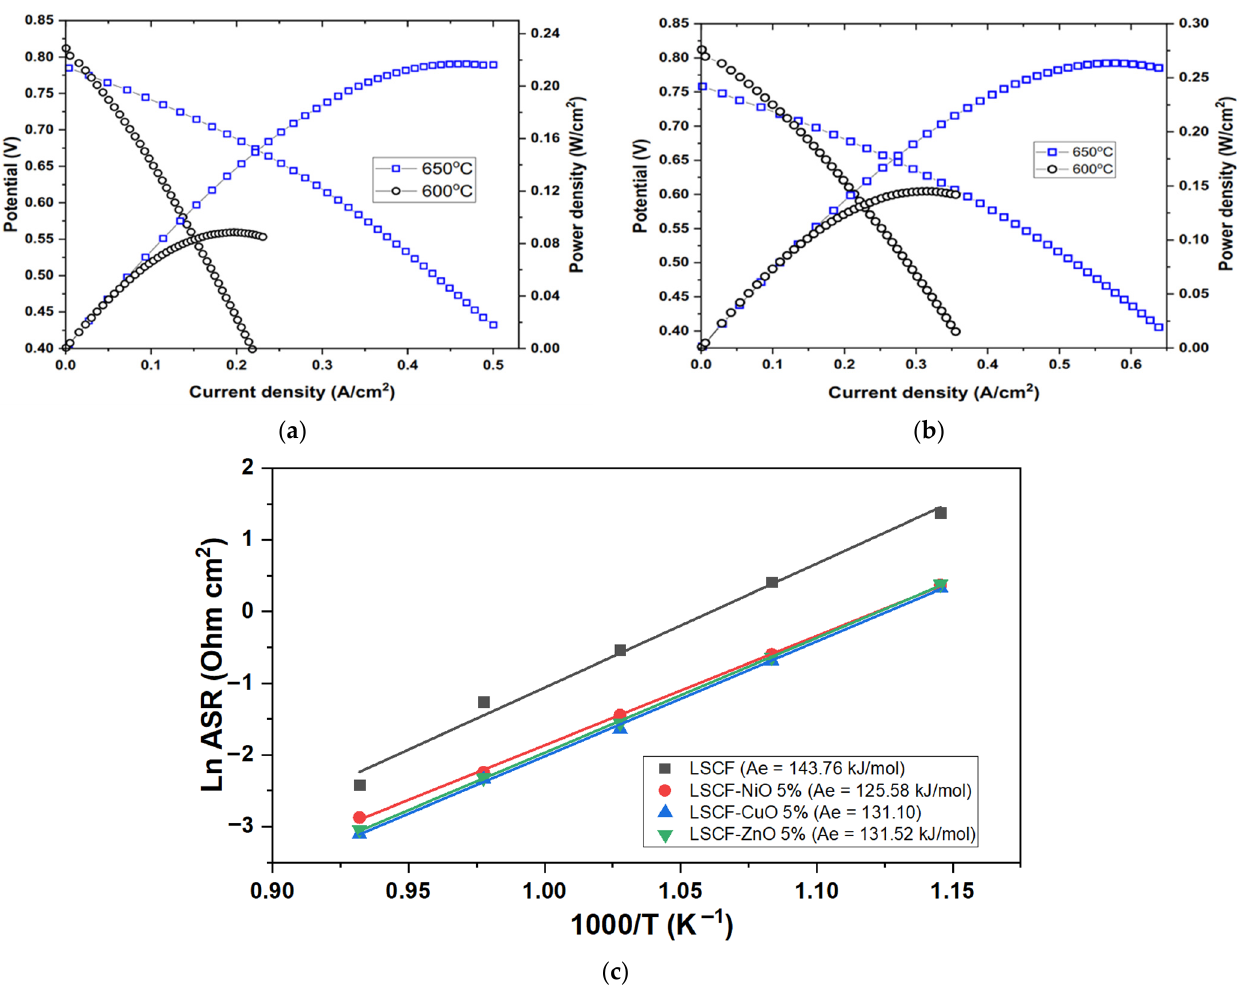
Figure 5. Cell voltage and power density for a single cell ( a ) bare LSCF cathode; ( b ) LSCF cathode with 5 wt% addition of NiO; and ( c ) activation energy of LSCF and LSCF with varies NiO loading content at intermediate operating temperature.